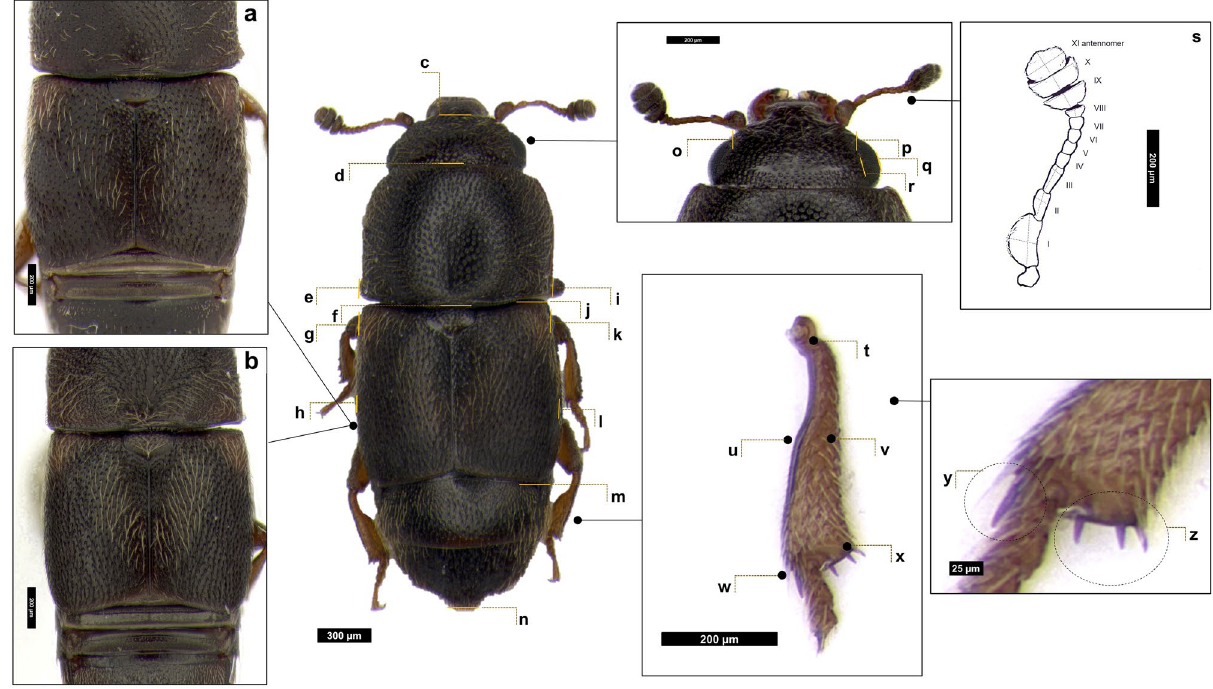
Figure 1. Dorsal view of Carpophilus truncatus . a-b: Coloration and apical shape of elytra, posterior shape of the pronotum. Morphometric measures: c-n: Body length; d-f: Pronotum length; j-m: Elytral length; h–l: Body width; e-i: Pronotum width; g-k: Elytral width; o-p: Intraocular distance at narrowest point; q-r: Eye width at widest point in dorsal view; s: Antennomers (I-XI) length and width; t-x: Metatibia total length; u-w: Metatibia partial length; w-x: Metatibia distal width; u-v: Metatibia proximal width; y: Number of spurs; z: Number of spines.